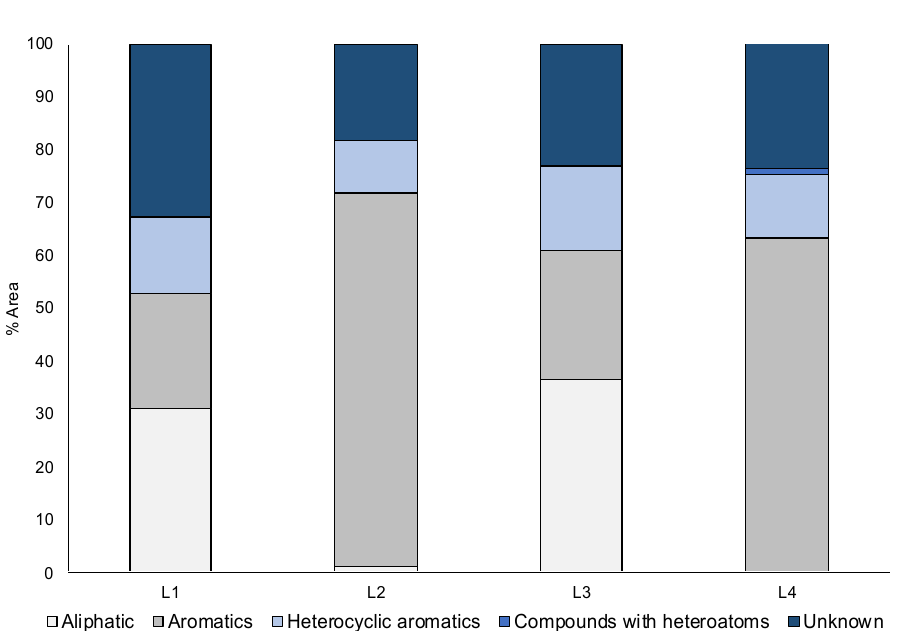
Figure 8. Liquid fraction qualitative characterization classified by aliphatic, aromatics, heterocyclic aromatics, compounds with heteroatoms, and unknown compounds.